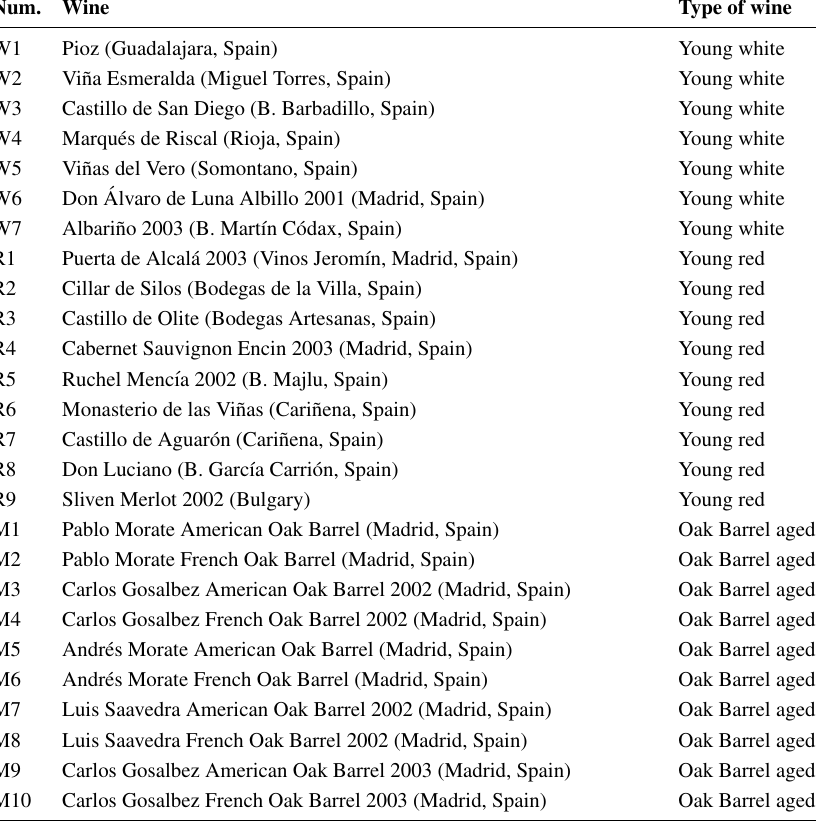
Table 1. Wine samples tasted by the sensory panel and measured by the